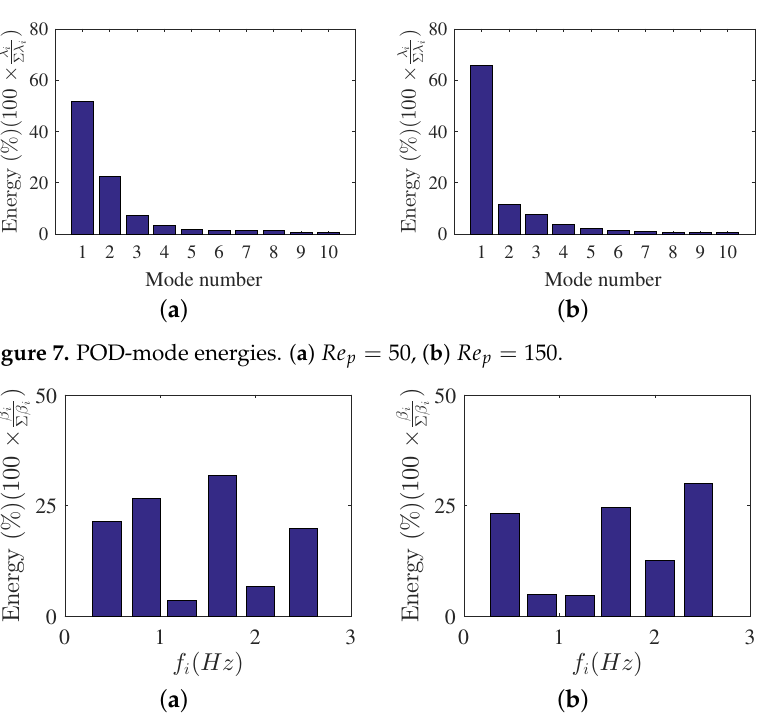
Figure 8. DMD-mode energies. ( a ) Re p = 50, ( b ) Re p =